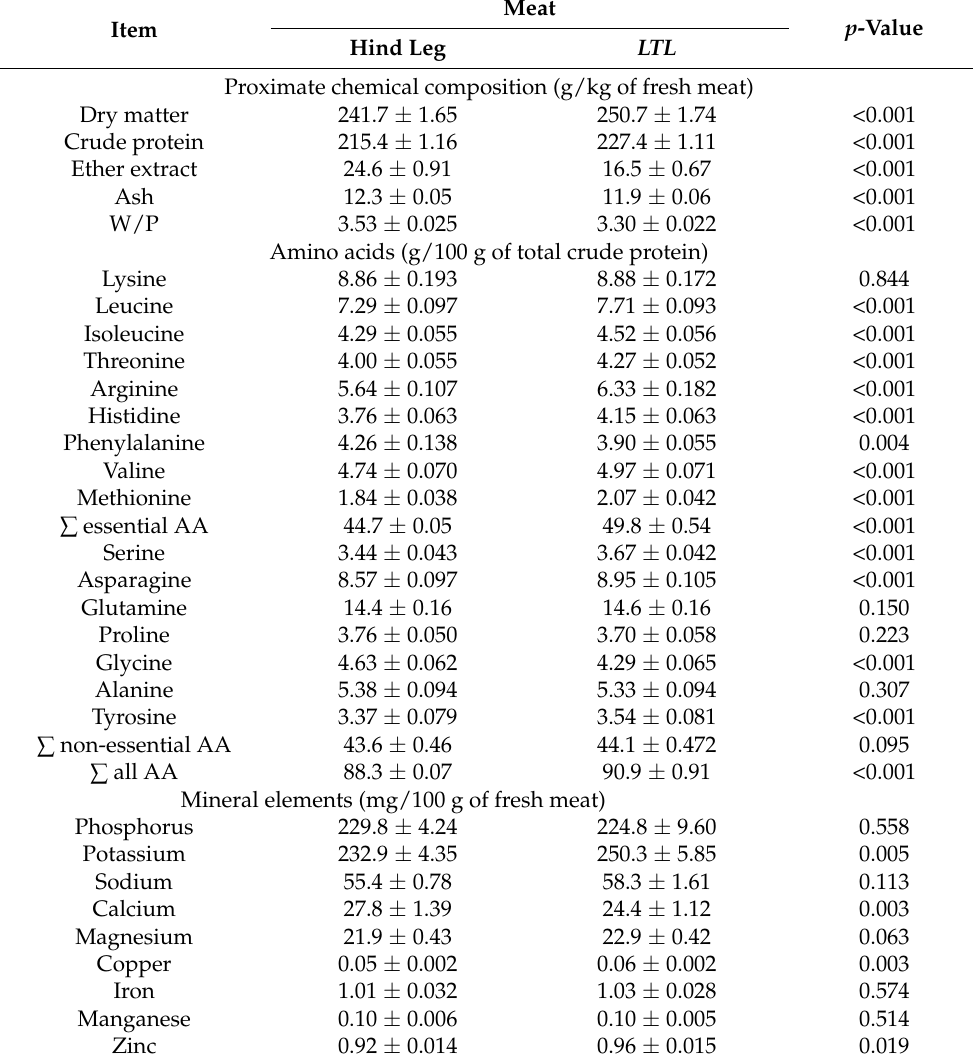
Table 2. Effect of the carcass part on meat composition of